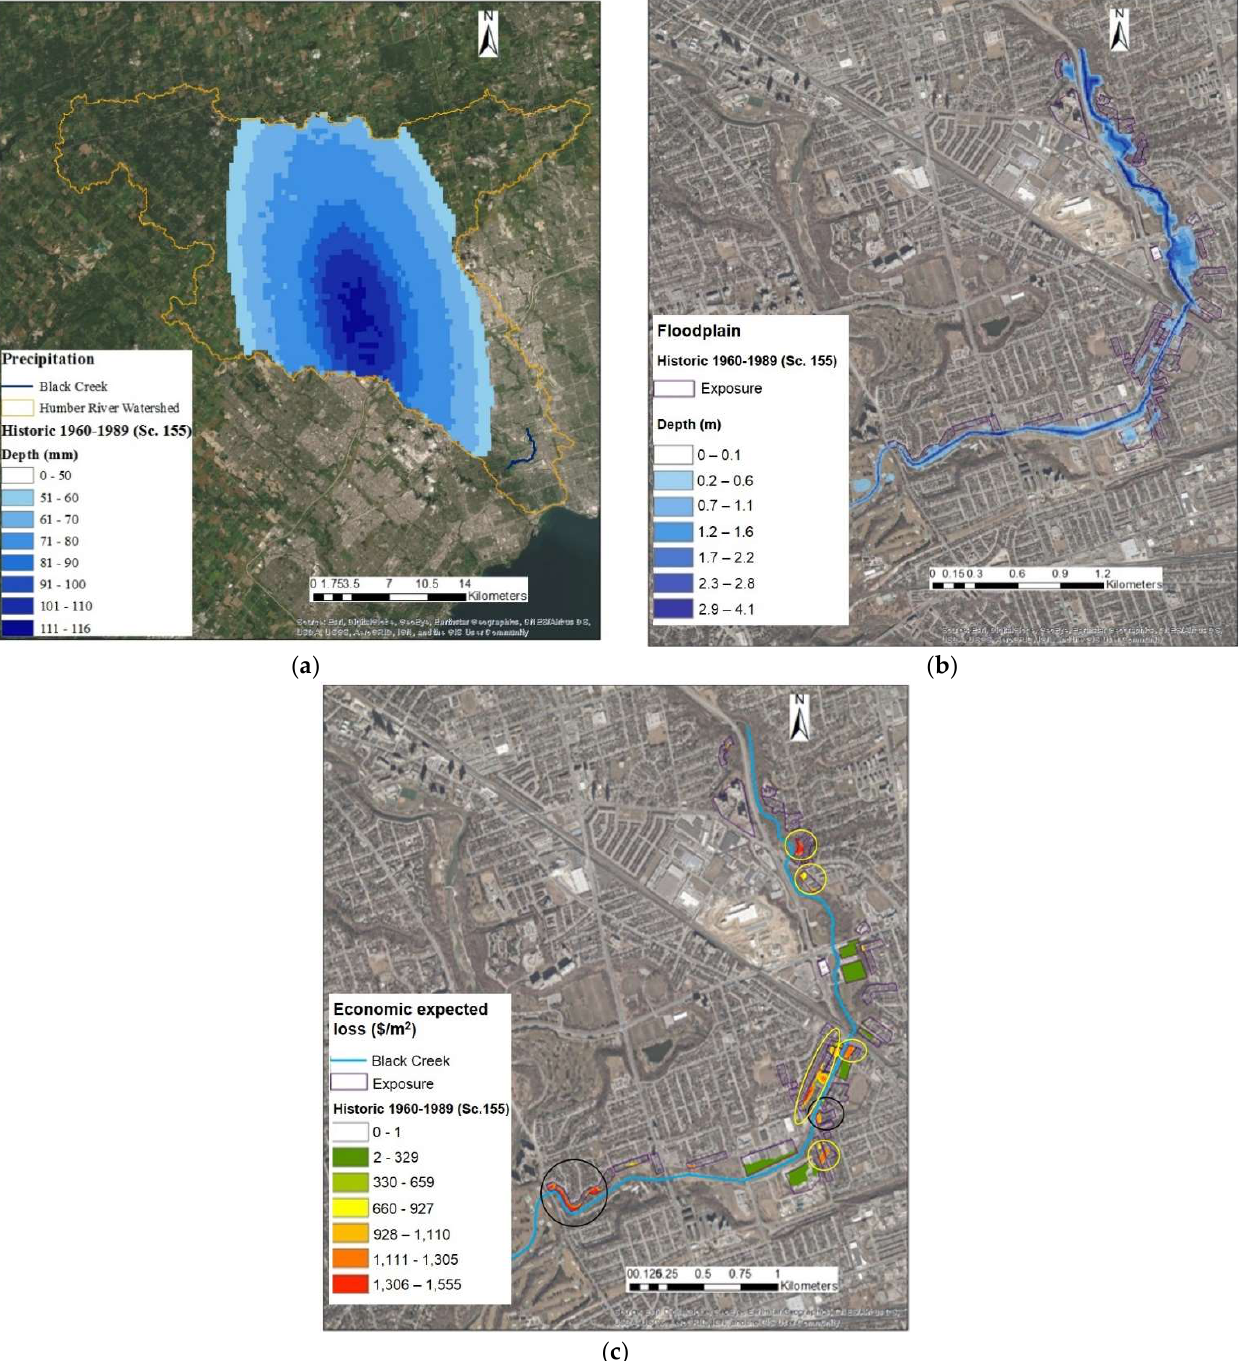
Figure 19. Results for the worst-case scenario of the historical period (Scenario 155). ( a ) Rainfall map; ( b ) floodplain map; ( c ) economic expected loss map